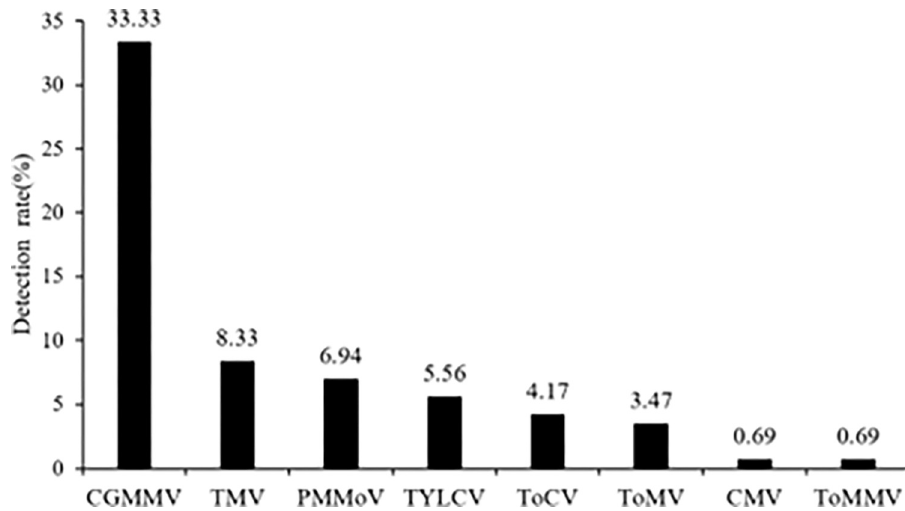
Fig 2. Detection of each virus in surface